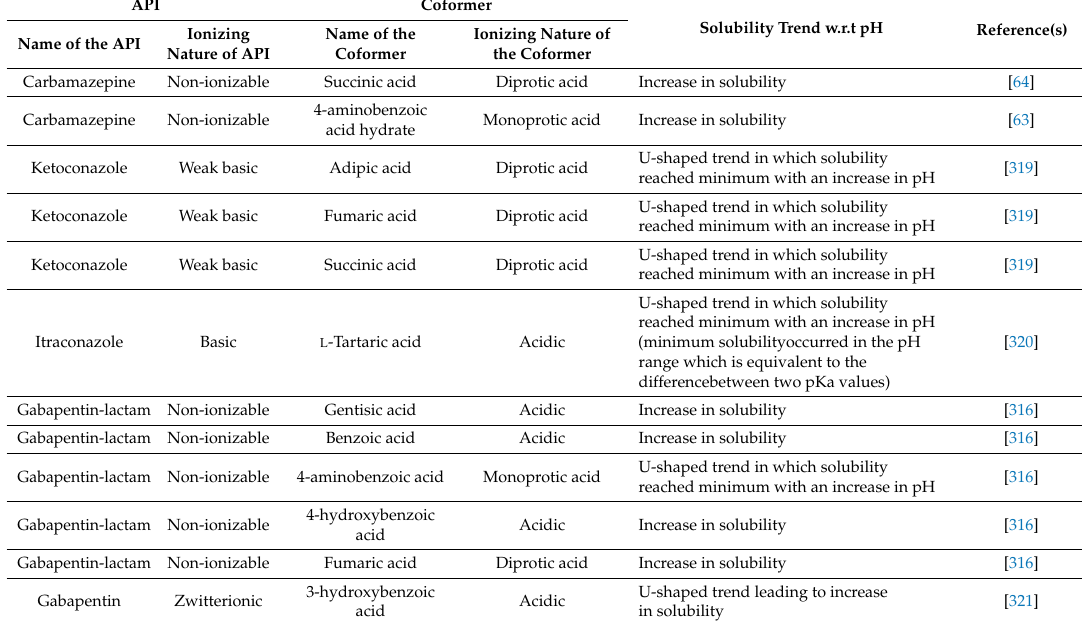
Table 11. Observations made from a few literature reports on pH-solubility behavior of cocrystals different API-coformer pairs having different ionization